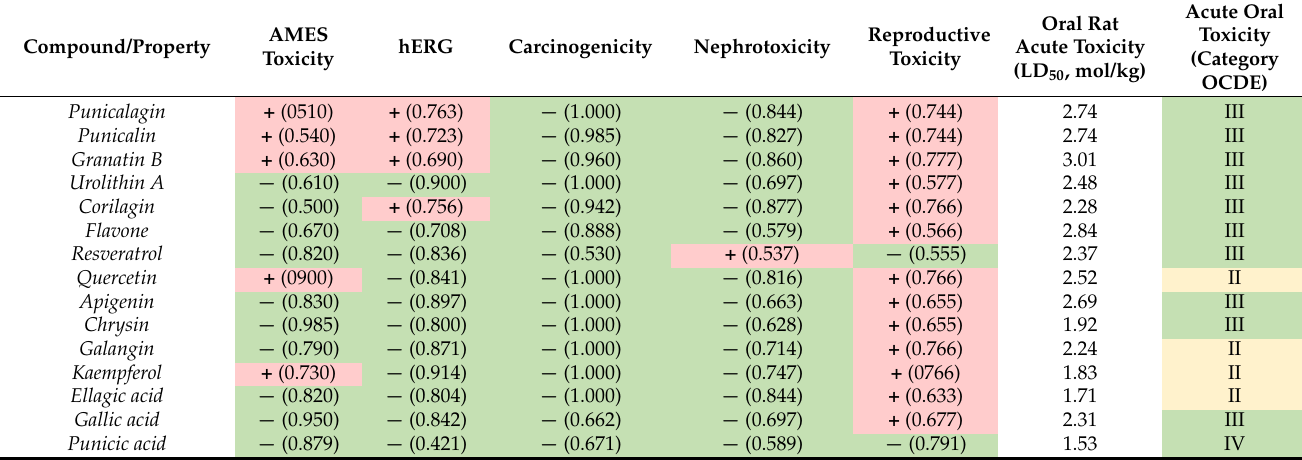
Table 5. Toxicity parameters predicted for major compounds by